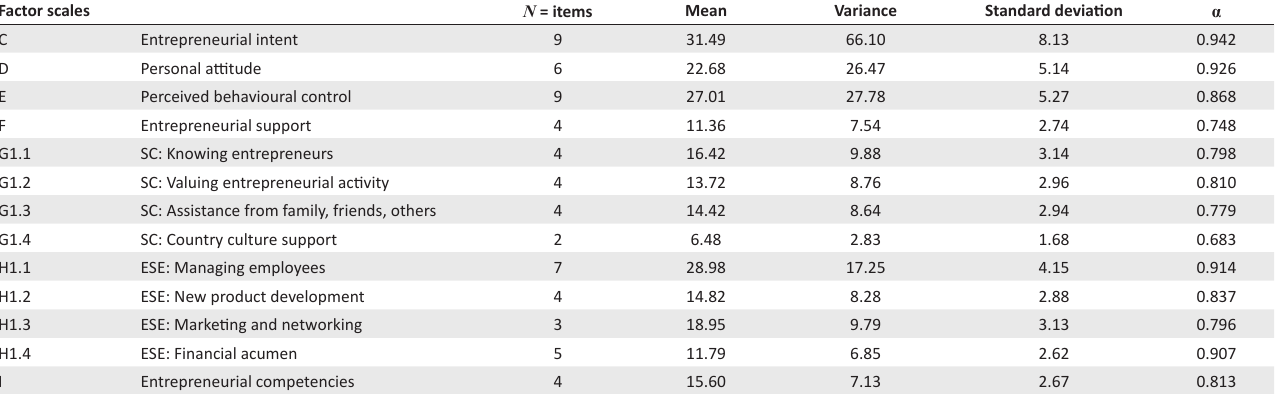
TABLE 5: Reliability of refined factor scales (Cronbach’s alpha coefficient) and summary of item analysis results pertaining to each of the 13 scales (Swanepoel & Nieuwenhuizen 2014). Factor scales N = items Mean